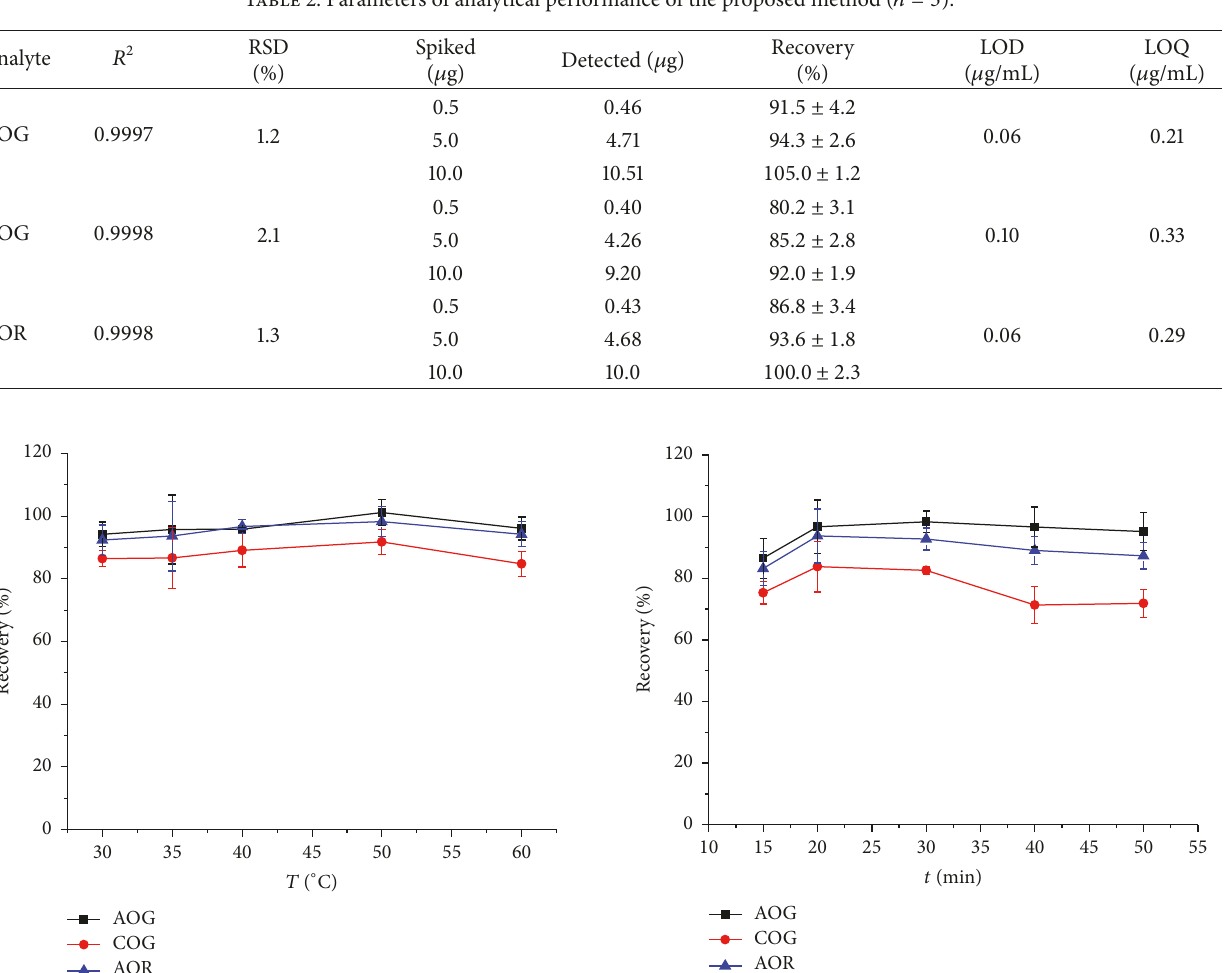
Table 2: Parameters of analytical performance of the proposed method ( 𝑛 = 3 ).